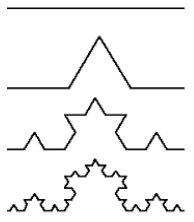
Figure 3. The Koch Figure 3. The Koch snowflake.